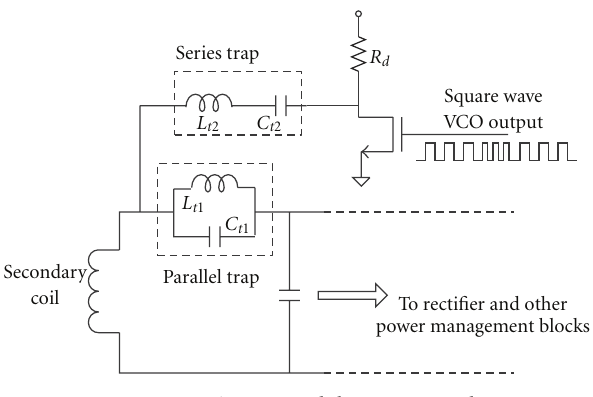
Figure 5: Gain stage and the trap networks.